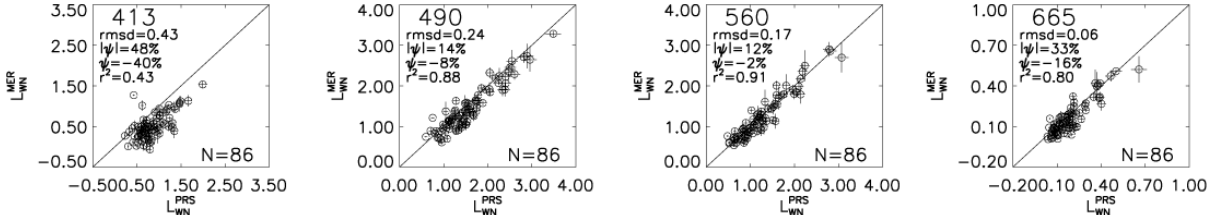
Fig. 2. As in Fig. 1 but for the 3rd